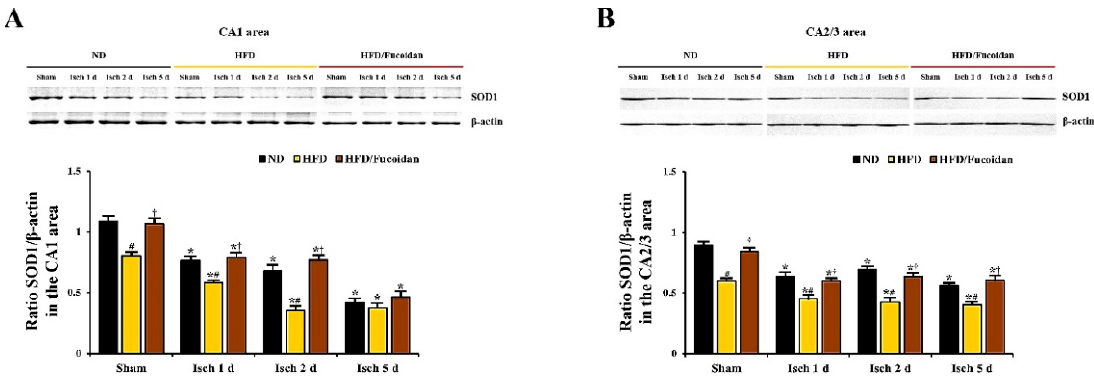
Figure 9. Western blot analysis of SOD1 in the CA1 ( A ) and CA2/3 ( B ) areas ( n = 6/group). Protein expression is normalized to β -actin. The bars indicate the means ± SEM. * P < 0.05 vs. each sham group, # P < 0.05 vs. ND-fed group, † P < 0.05 vs. HFD-fed group.